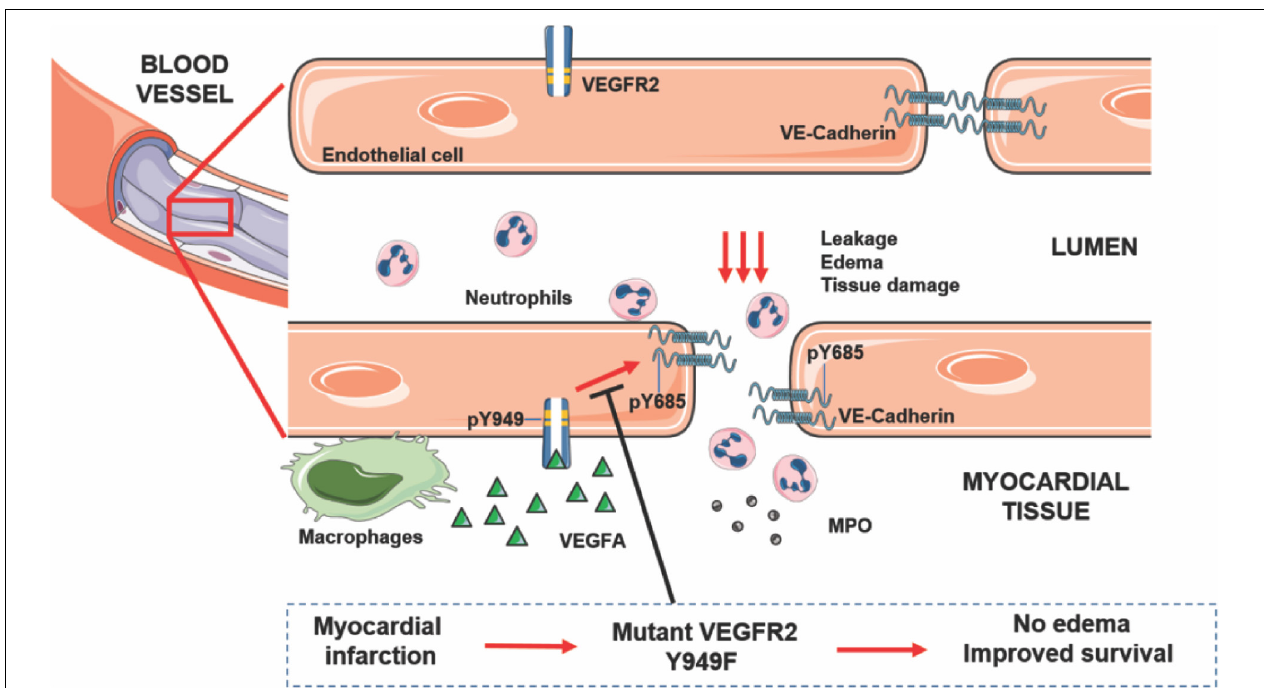
FIGURE 5 | VEGFA/VEGFR2 regulates edema and tissue damage in myocardial infarction. Activation of VEGFR2 on endothelial cells leads to phosphorylation on Y949 and subsequently, phosphorylation of VE-cadherin on Y685, leading to dismantling of adherens junctions and leakage, edema, neutrophil infiltration, MPO release, and tissue damage. Mutation of Y949 in VEGFR2 halts edema and improves survival after myocardial